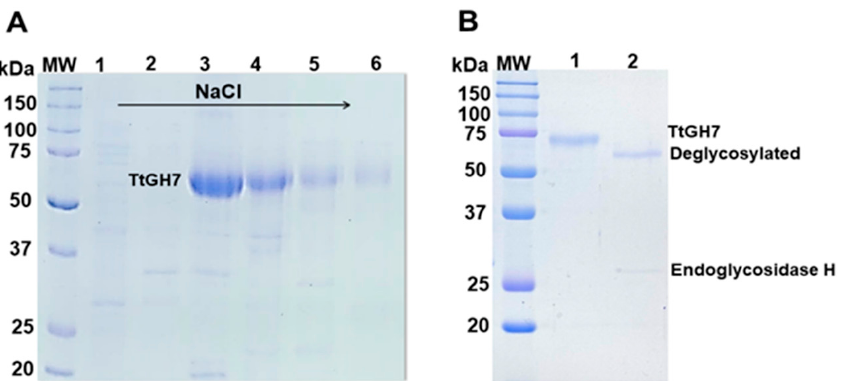
Figure 3. Purification of the recombinant endoglucanase Tt Cel7B from T. terrestris expressed in A. nidulans A773. ( A ) SDS-PAGE fractions (lines 1–6) eluted from the ion-exchange Hiprep Q-FF